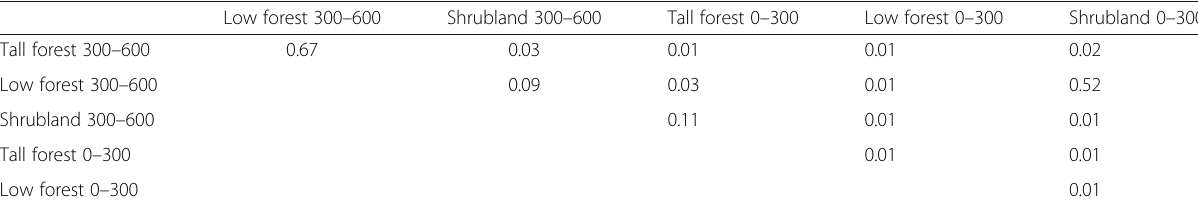
Table 4 Probability ( p value) of the multiple median comparison tests, for the five largest individuals within each cover type-distance class